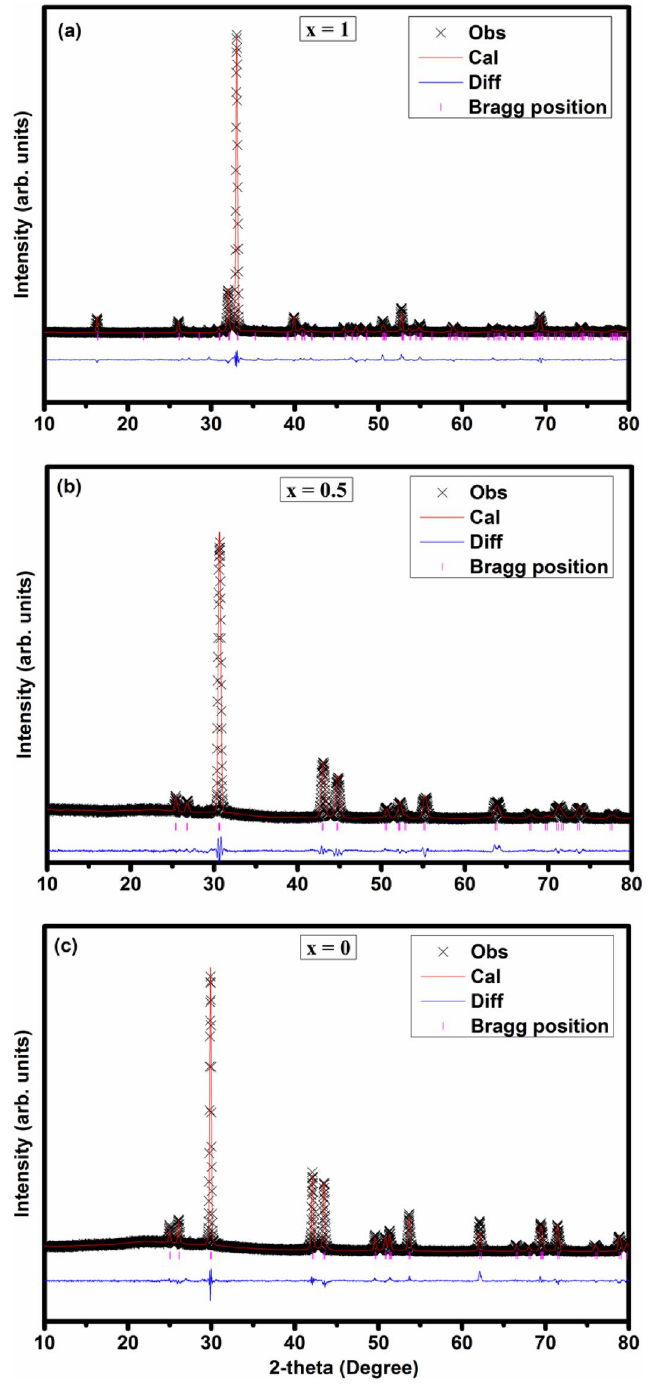
Figure 2. Rietveld Refined data of representative GeTe 1−x Se x samples (x = 0, 0.5 and 1.0) to verify structural parameters and volume of unit cells show higher values due GeSe orthorhombic phase formation. The increase in the FWHM of the peaks indicates a reduction in coherently scattering domains. It can be correlated with the local distortion created by Se in the GeTe structure due to its smaller atomic size of Se. To understand the structural changes in PCM materials two parameters are considered to be important, viz. ionicity (r σ ′ ) and hybridization (r π−1 ) 21 . The parameter r σ ′ is determined by the electronegativity difference of p-orbitals of two nearby atoms and r π −1 is the quantification of covalency. The rhombohedral structure of GeTe is characterized by low r σ ′ and low r π−1 parameter in the r σ ′ vs. r π−1 map 21 . In contrast, GeSe is located at a